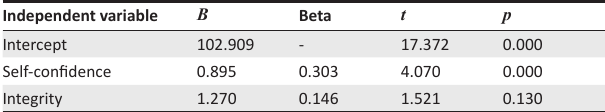
TABLE 6: Results of multiple regressions of authentic leadership scales on team commitment.